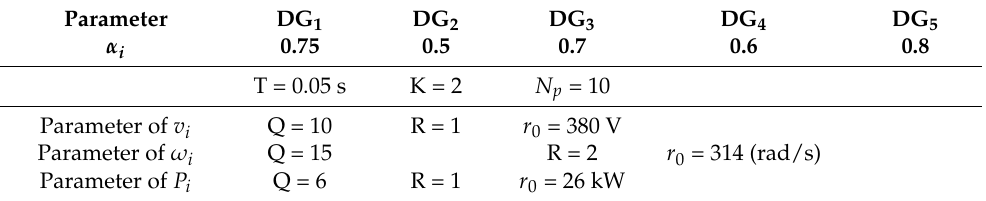
Table 2. Parameters of the self-triggered MPC control.